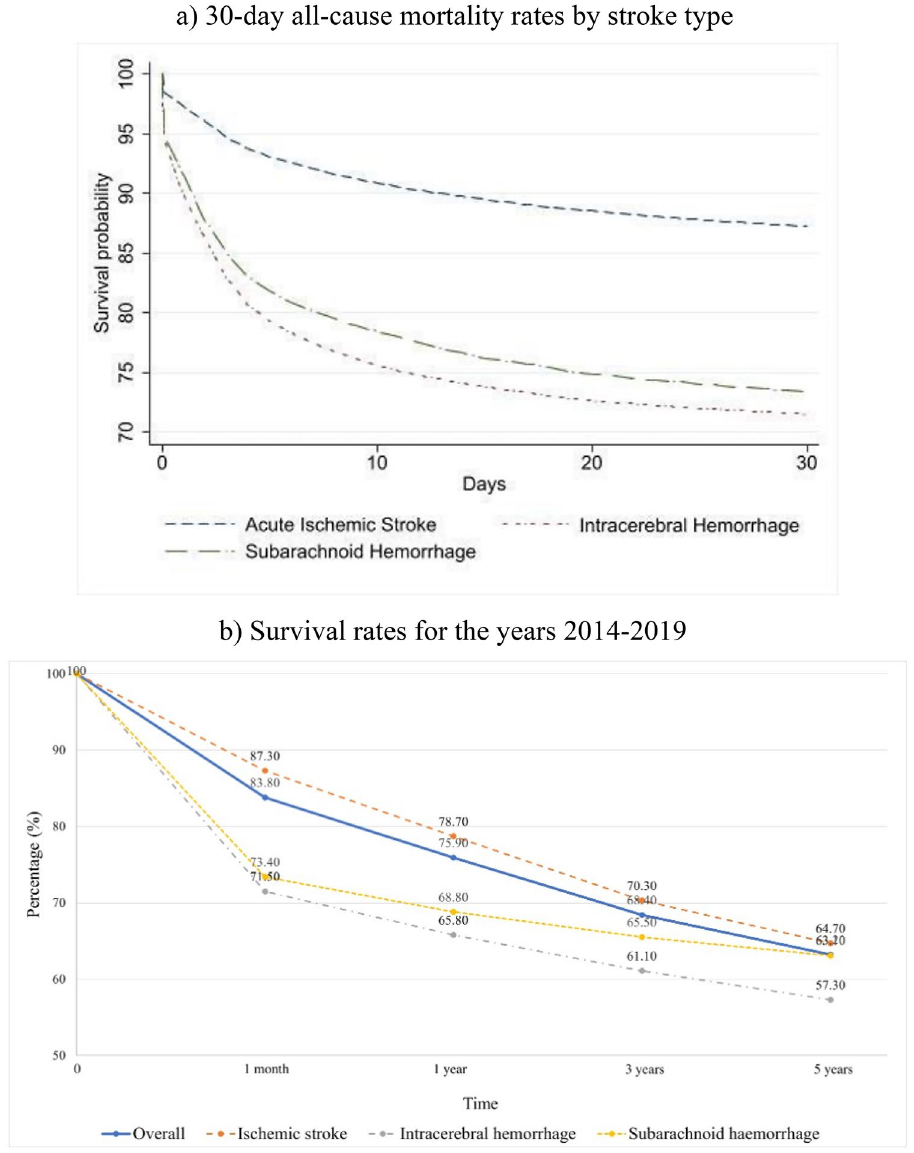
Figure 4. Kaplan–Meier survival curves due to all-cause mortality based on discharge status: ( a ) 30-day all- cause mortality rates by stroke type ( b ) Survival rates for the years